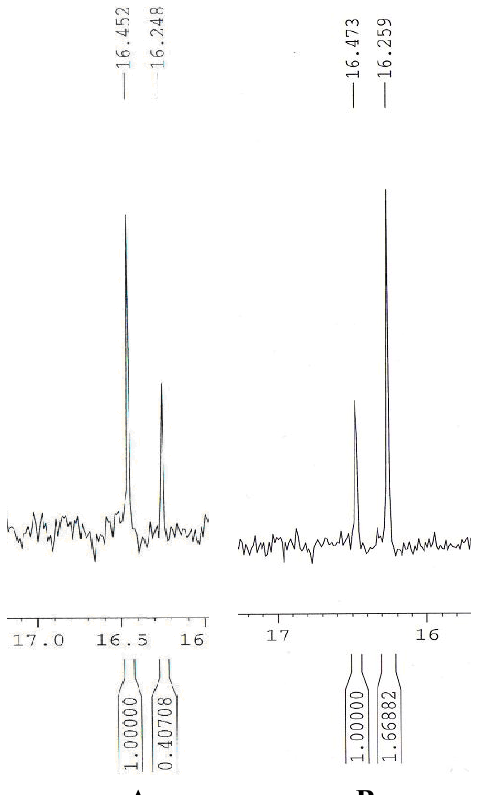
Figure 1. 31 P-NMR spectra of biotransformation products recorded with cyclodextrin: A , fresh cells of C.echinulata , second day of biotransformation, predominant enantiomer defined as R isomer; B , cells of A. fumigatus preincubated under starvation conditions, first day of biotransformation, predominant enantiomer defined as S